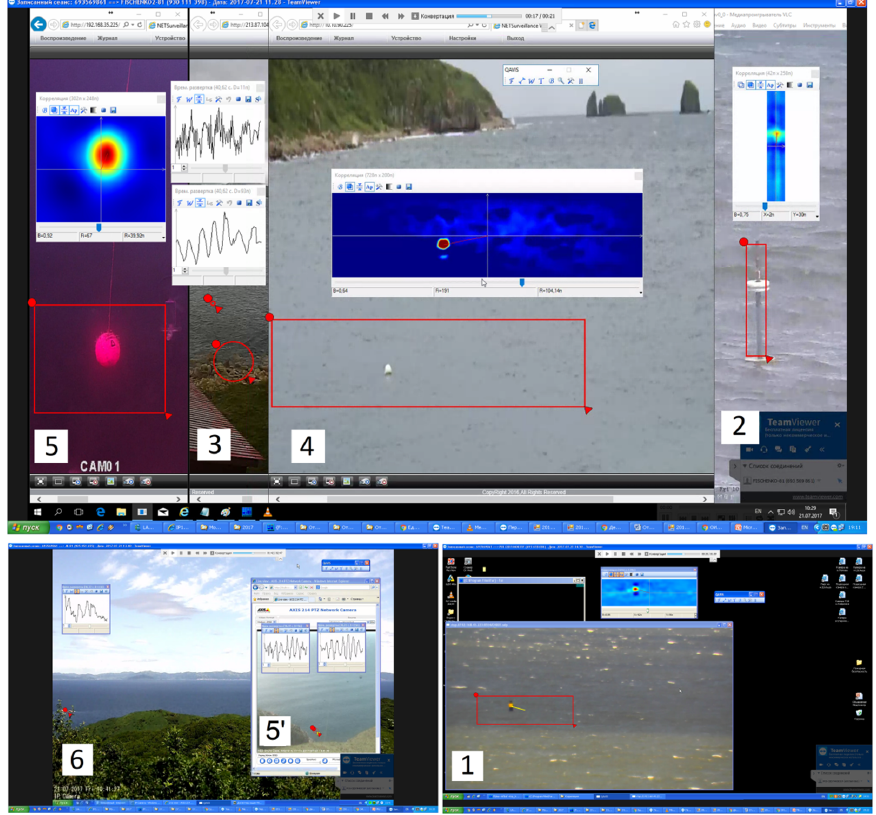
Figure 2. Synchronous measurements in real time of wave signals and their assessments at 6 points in Peter the Great Bay: ( 5 ) Cape Schultz, an underwater camera in Vityaz Bay, horizontal dis- placements of the underwater marker under the action of fluid movements caused by surface waves is measured; ( 3 ) Vostok Bay, the sea surface brightness signal, modulated by the passing waves, and the brightness signal of the region of the wave ashore are measured; ( 4 ) Bolshoi Pelis island, the signal of vertical movements of the float on the sea surface is measured; ( 2 ) Alekseev Bay on Popov Island, the wave signal is measured on base a “videowavemeter”; ( 6 ) Furugelm Is- land, the brightness signal in the breaking zone of waves emerging on a small rocky island is measured; ( 5′ ) Cape Schultz, view towards the Sea of Japan, the signal of the sea surface brightness modulation by passing waves is measured; ( 1 ) roof of the POI FEB RAS, view of the Amurskiy Bay, the signal of vertical movements of the navigational buoy under the action of waves is measured.